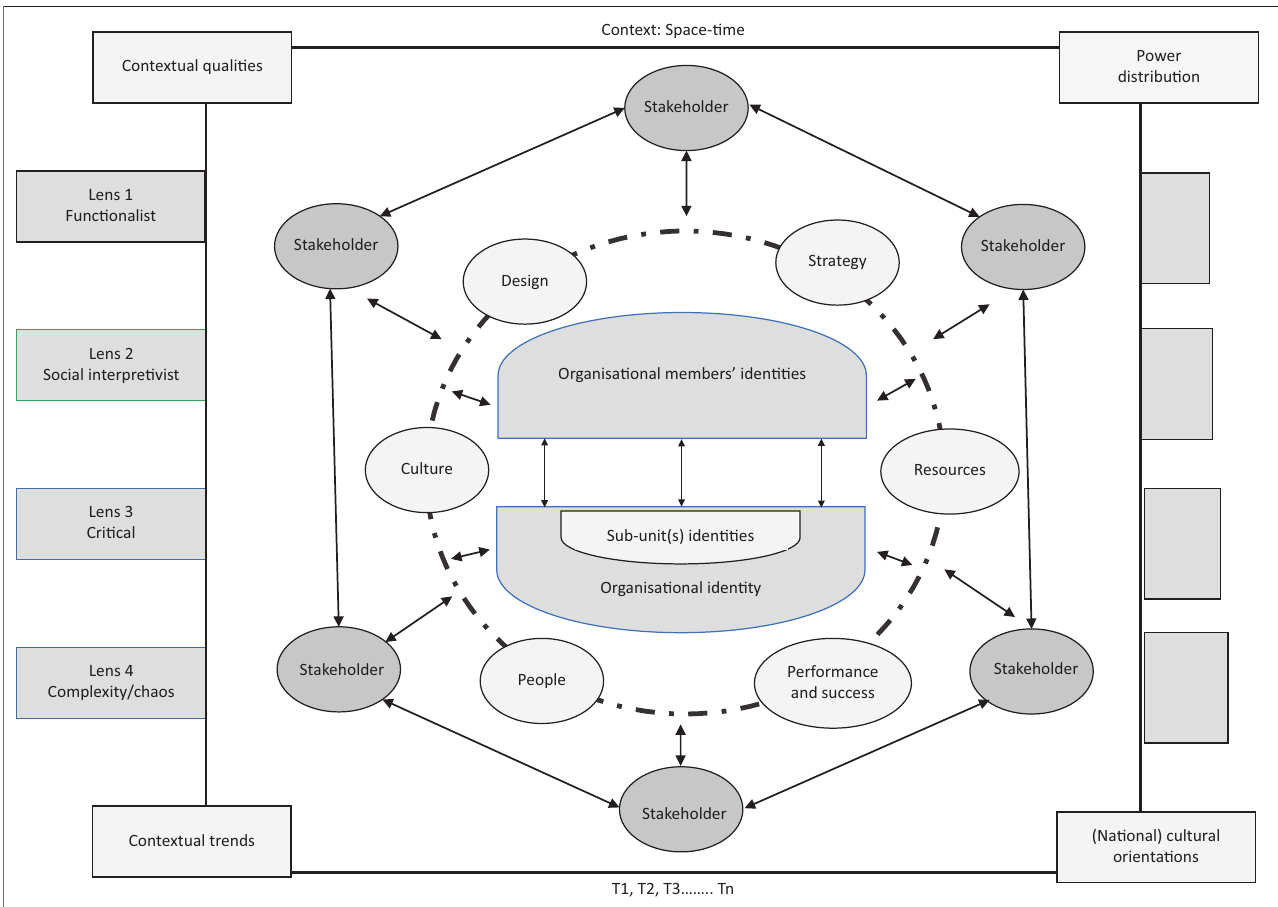
FIGURE 2: Proposed Organisational Identity Landscape as meta-theoretical framework to map the territory called ‘Organisational